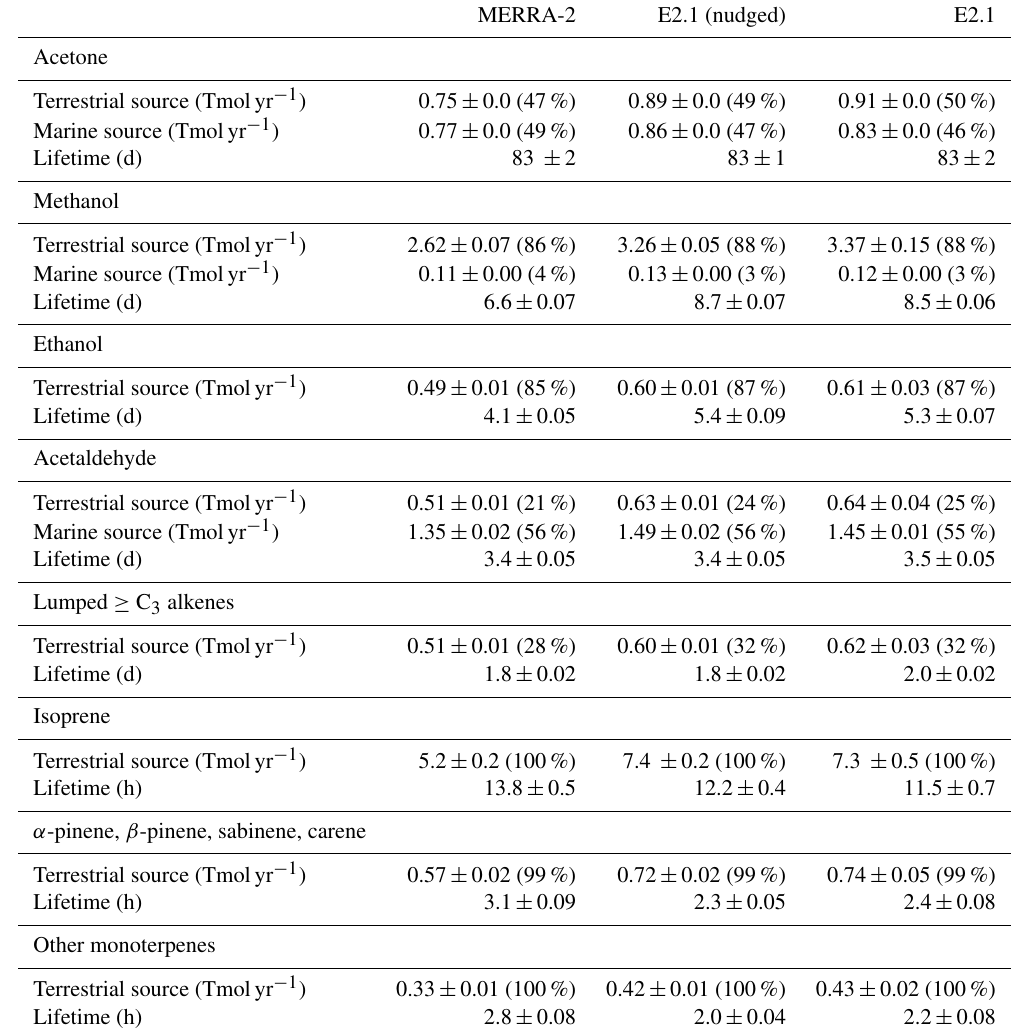
Table 7. Biogenic emissions and tropospheric lifetimes of select NMHC species for